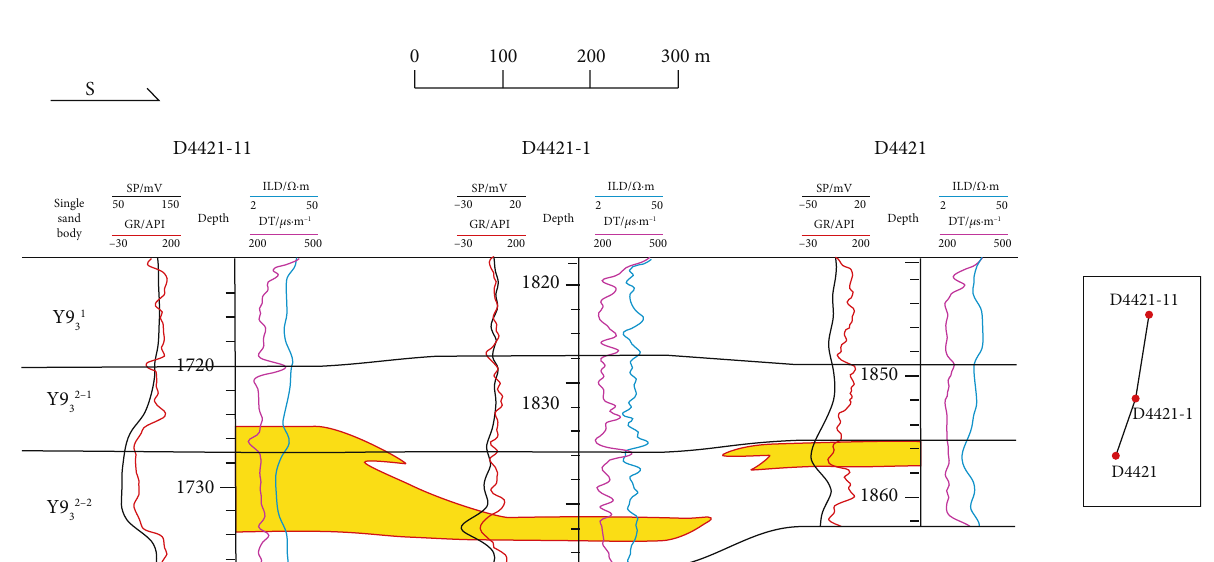
Figure 11: Schematic diagram of the sand body